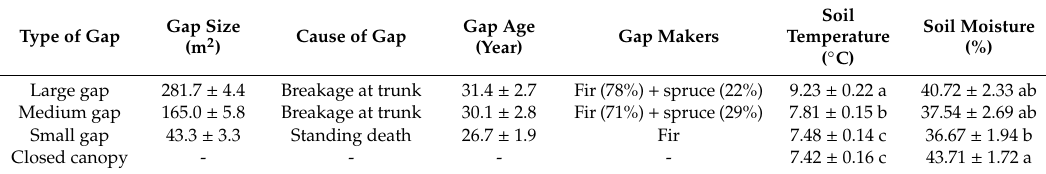
Table 1. Characteristics of the four treatments (mean ± SE, n =